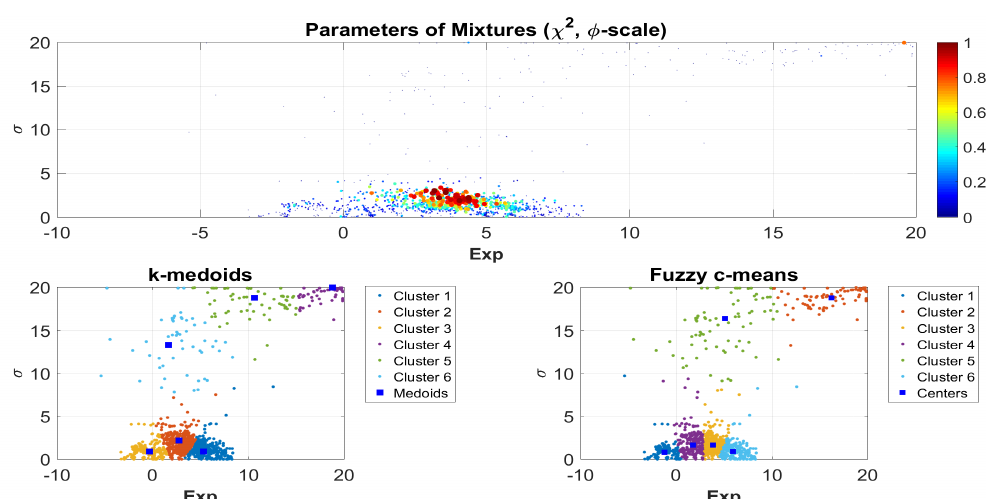
Figure A23. Clustering the mixture parameters (minimizing χ 2 estimates, φ scale).